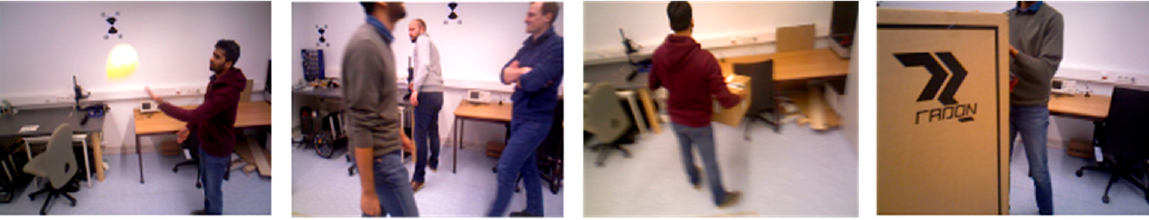
Figure 8. Example RGB frames from Bonn dataset.